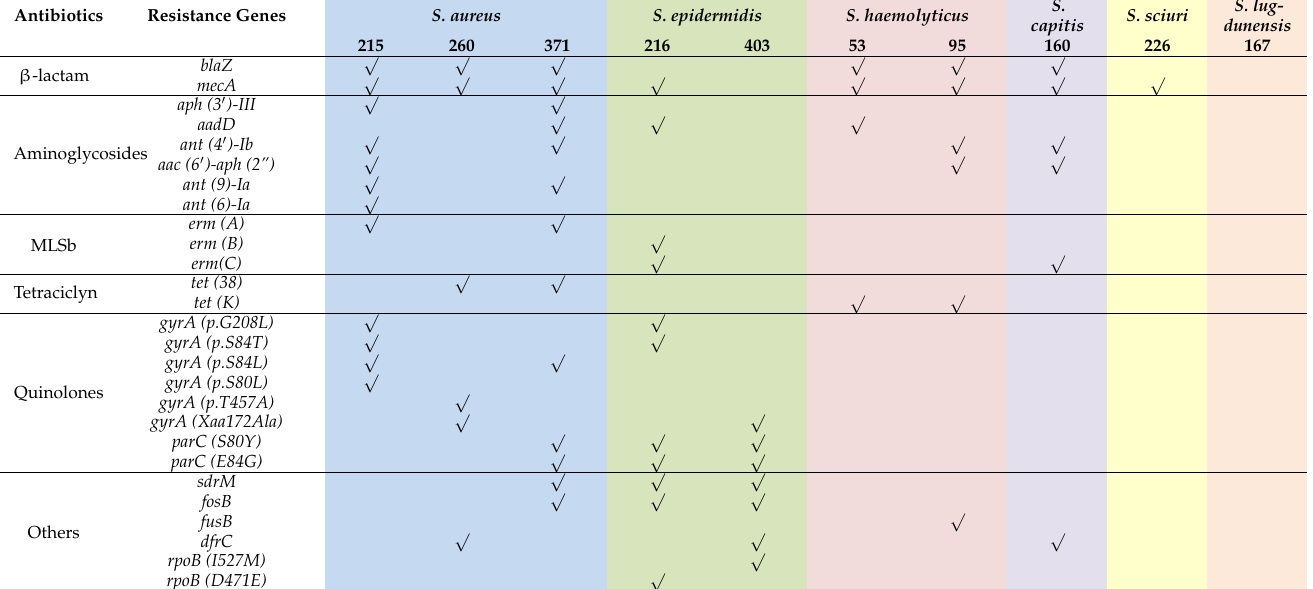
Table 4. Genotypic resistance profile with respective genes of Staphylococcus spp. isolates included in the